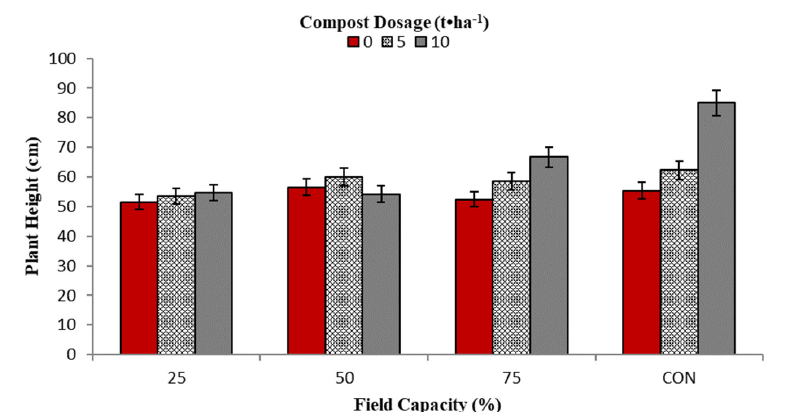
Figure 5. Effect of water deficit and compost dosage on plant height of okra at 8 weeks 0, 5 and 10 represent compost dosage. Data in the interaction analysed with Least Squares Means, and means separated with LSD.